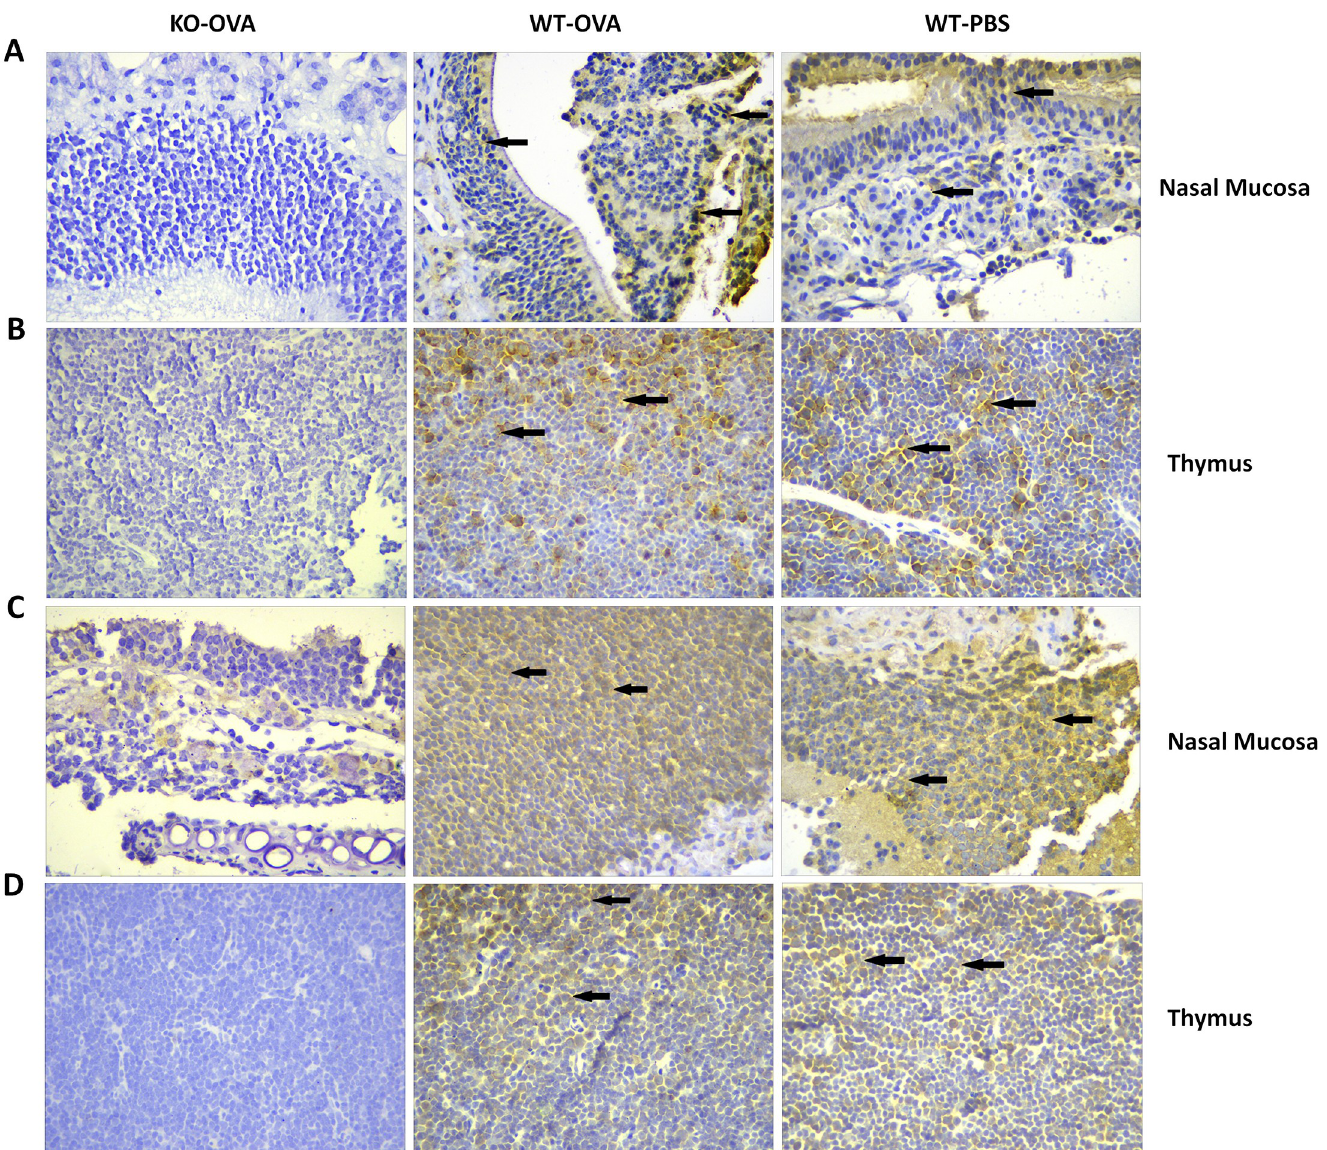
Fig 2. The expression levels of H2-Eb1 and H2-Ab1 in the nasal mucosa and thymus of different groups of mice, as determined by IHC. The panels in A show the H2-Eb1 expression levels in the nasal mucosa for the three groups of mice. The staining of H2-Eb1 in the KO-OVA mice was weakly positive, while there was strong staining in the samples from the other two groups. The panels in B show the H2-Eb1 expression in the thymus, which was similar to that in the nasal mucosa. The panels in C show the H2-Ab1 expression in the nasal mucosa for the different groups of mice. The H2-Ab1 staining in the KO-OVA mice was weakly positive, while the H2-Ab1 staining in the other two groups was strongly positive. Panel D shows the H2-Ab1 expression in the thymus for the three different groups of mice. The H2-Ab1 staining in the KO-OVA mice was weakly positive, while the staining in the WT-OVA and WT-PBS groups was strongly positive.